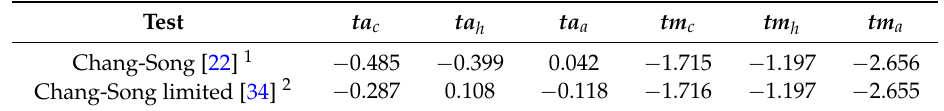
Table 5. 3rd generation panel unit root test result